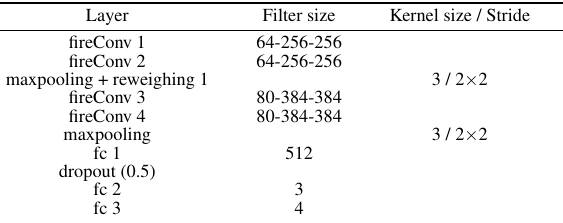
Table 2. Network parameters of odometry regression